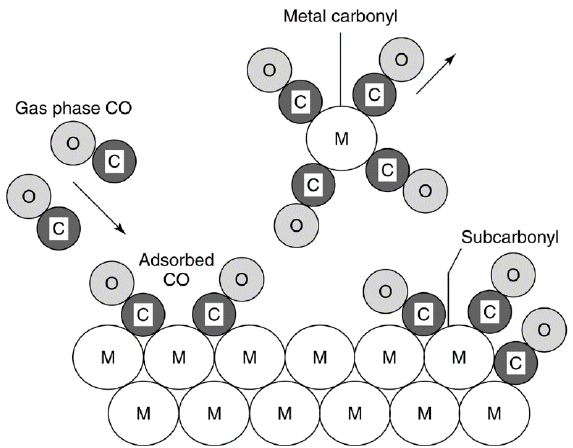
Figure 20. Formation of volatile tetra-nickel carbonyl at the surface of nickel crystallite in CO atmosphere. Reproduced from [8]. Copyright 2006,